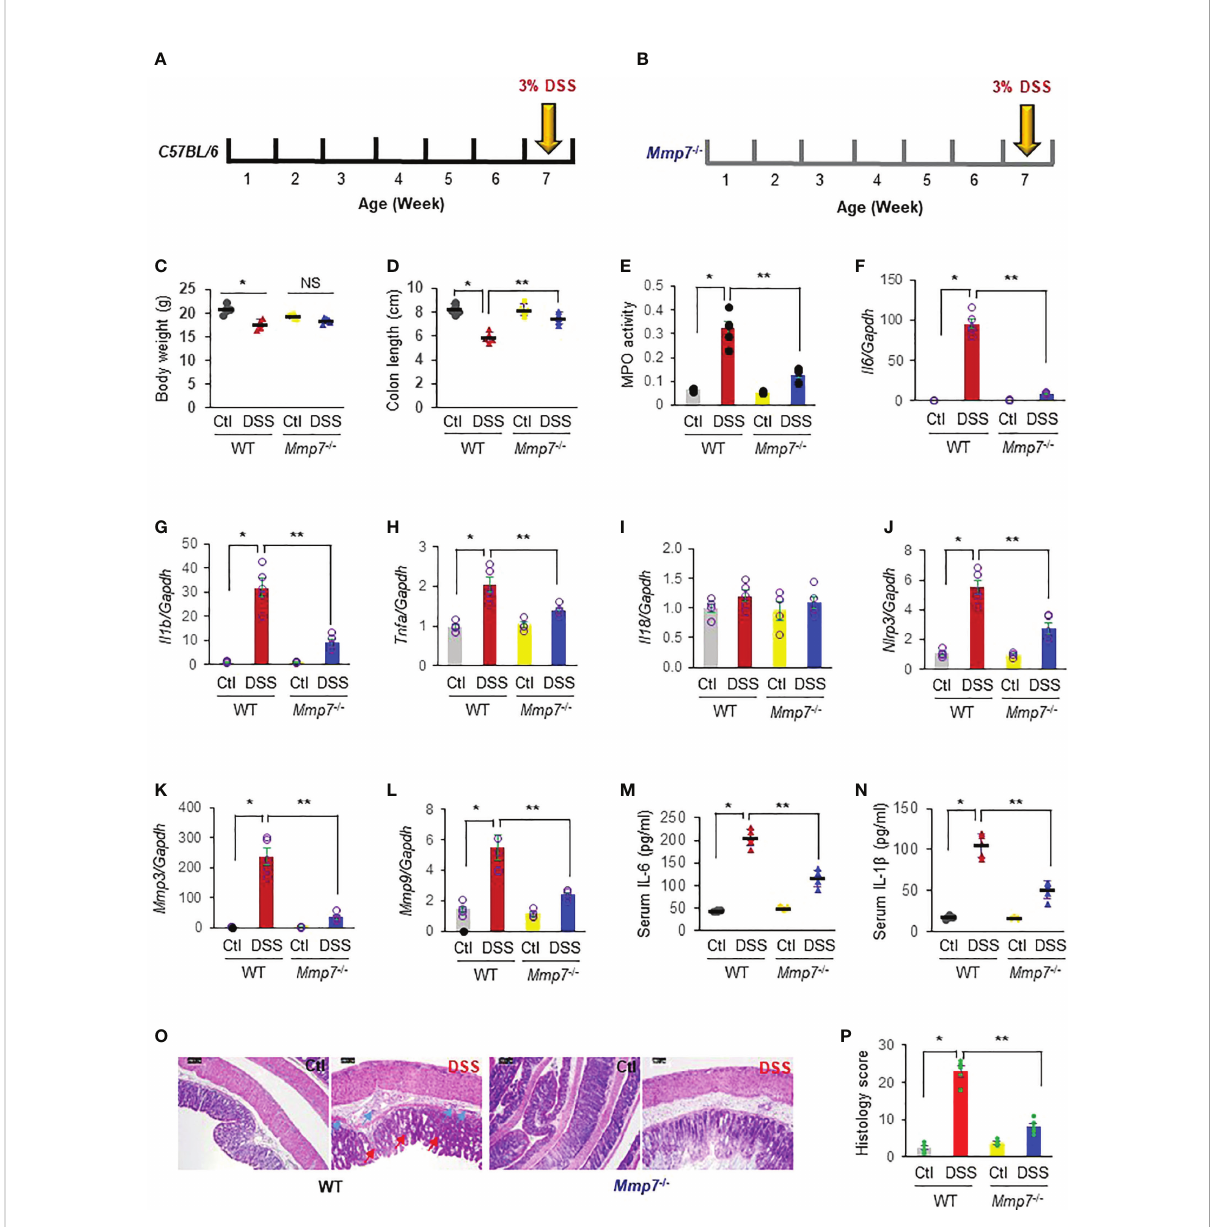
FIGURE 4 MMP-7 de fi ciency ameliorates DSS-induced colitis. Colitis was induced with 3% DSS in drinking water in C57BL/6 (A) and Mmp7 -/- (B) mice for 7 days. (C) Body weight. (D) Colon length. Colon tissue was collected for detection of myeloperoxidase (MPO) activity (E) and mRNA levels of in fl ammation-related genes. Messenger RNA (mRNA) levels of Il6 (F) , Il1b (G) , Tnfa (H) , Il18 (I) , Nlrp3 (J) , Mmp3 (K) , and Mmp9 (L) were quanti fi ed by RT-qPCR. Serum levels of IL-6 (M) and IL-1 b (N) were assessed by ELISA. (O) Histologic staining (H, E) of the colons. Green arrow, in fl ammatory in fi ltrate. Red arrow, distorted crypt. (P) Histological colitis score of the colons. n=4 or 5. * p <0.05 vs wild type control. ** p <0.05 vs wild type mice with DSS. NS, not signi fi